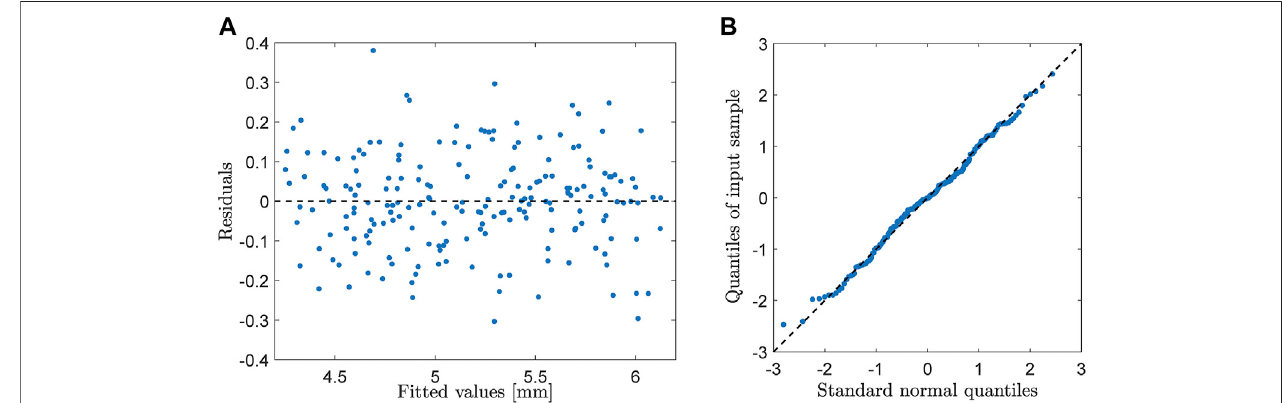
FIGURE 9 | Analysis of QoI residuals with respect to PCE: (A) Tukey-Anscombe plot and (B) Q-Q plot.